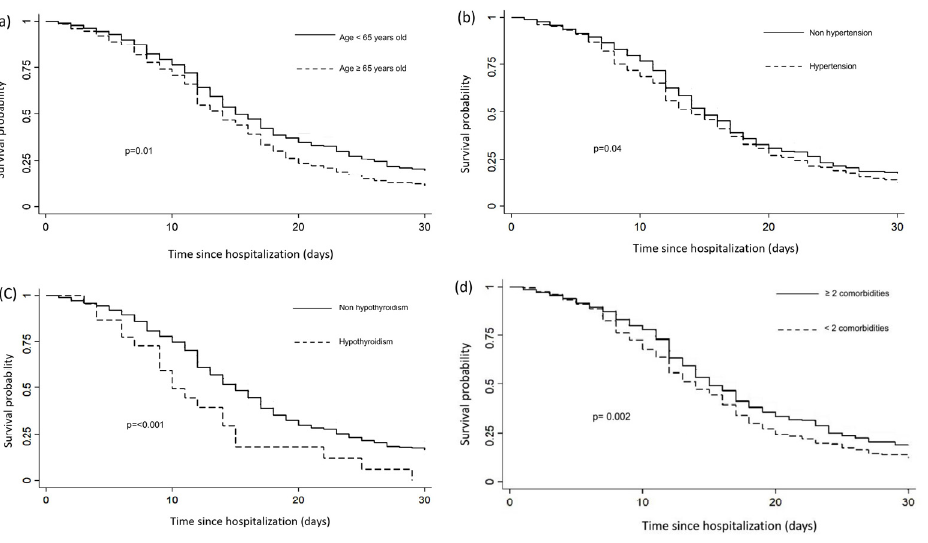
Figure 3. Thirty-day survival of hospitalized COVID-19 patients after hospital admission, stratified by age ≥ 65 years ( a ) hypertension, ( b ) hypothyroidism, ( c ) ≥ 2 comorbidities, and ( d ) (n = 1215).